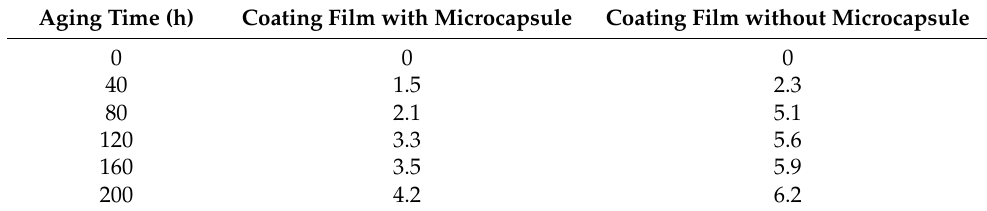
Table 7. Chromatic aberration of coating film under UV aging environment.